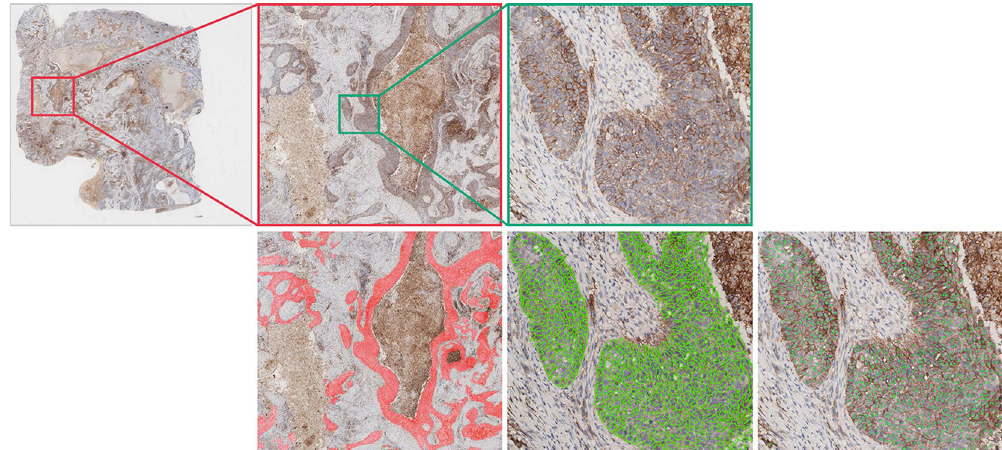
Figure 2. Examples of intermediate images in the ATPSS pipeline. From left to right of the top row is the original PD-L1 IHC images with different scales. From left to right of the bottom row: tumor area segmentation result, positive membrane detection result, and tumor nuclei detection result.